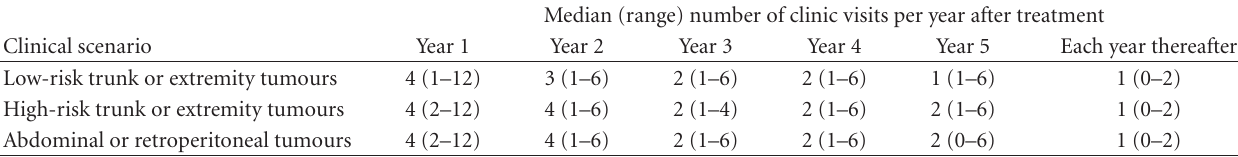
Table 2: Number of clinic visits per year after treatment by clinical scenario. Median (range) number of clinic visits per year after